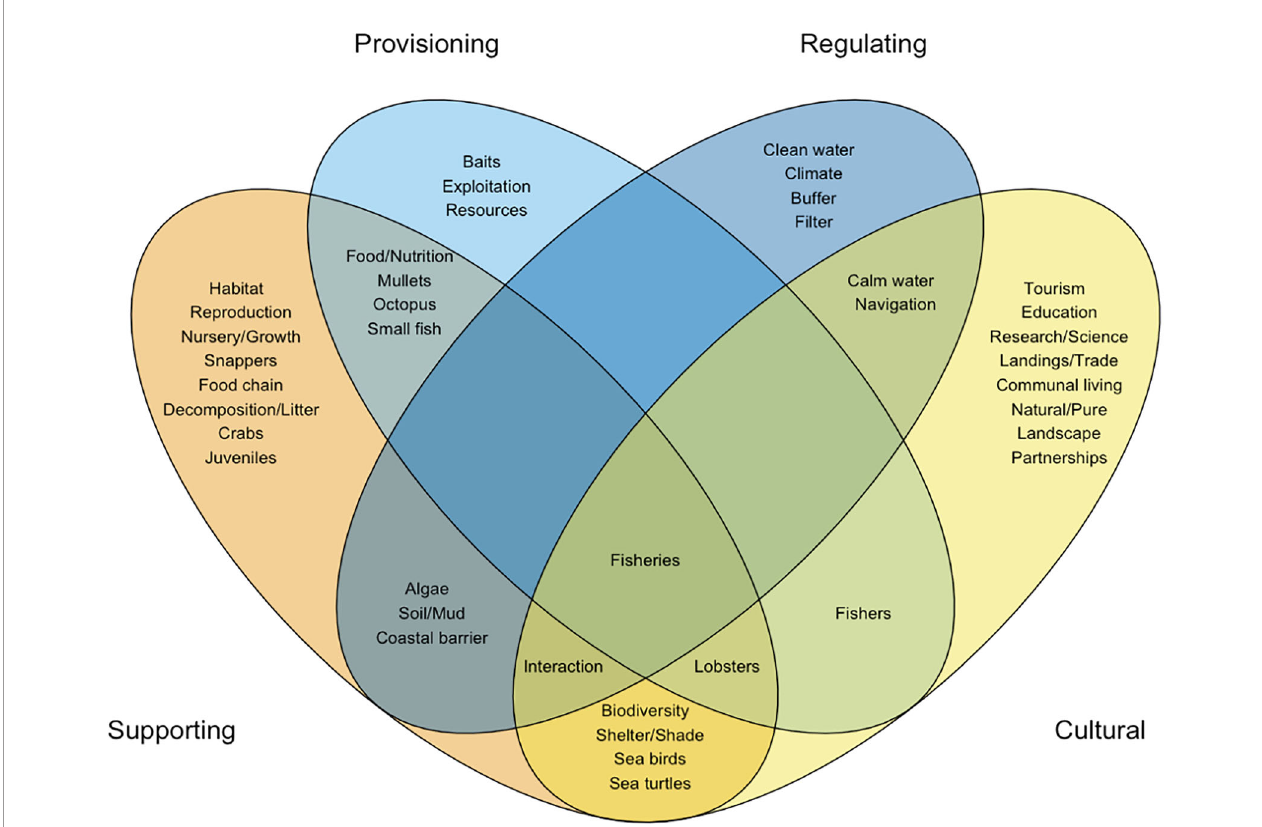
FIGURE 1 | Venn diagram depicting interactions among mangrove ecosystem services represented by keywords extracted from a fi shers ’ LEK study. Cultural Domain Analysis was used to assign keywords to different ecosystem services categories ( ‘ domains ’ ). Visualization only includes main